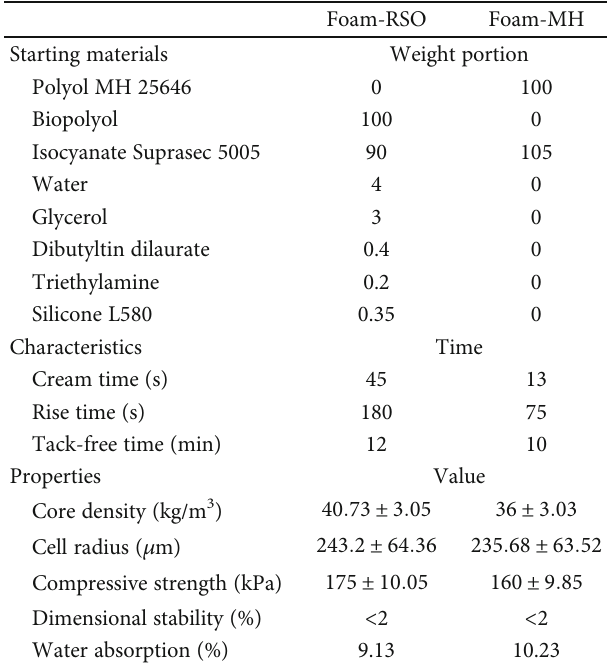
Table 2: Raw materials, characteristics, and properties of foams. Foam-RSO Foam-MH Starting materials Weight portion Polyol MH